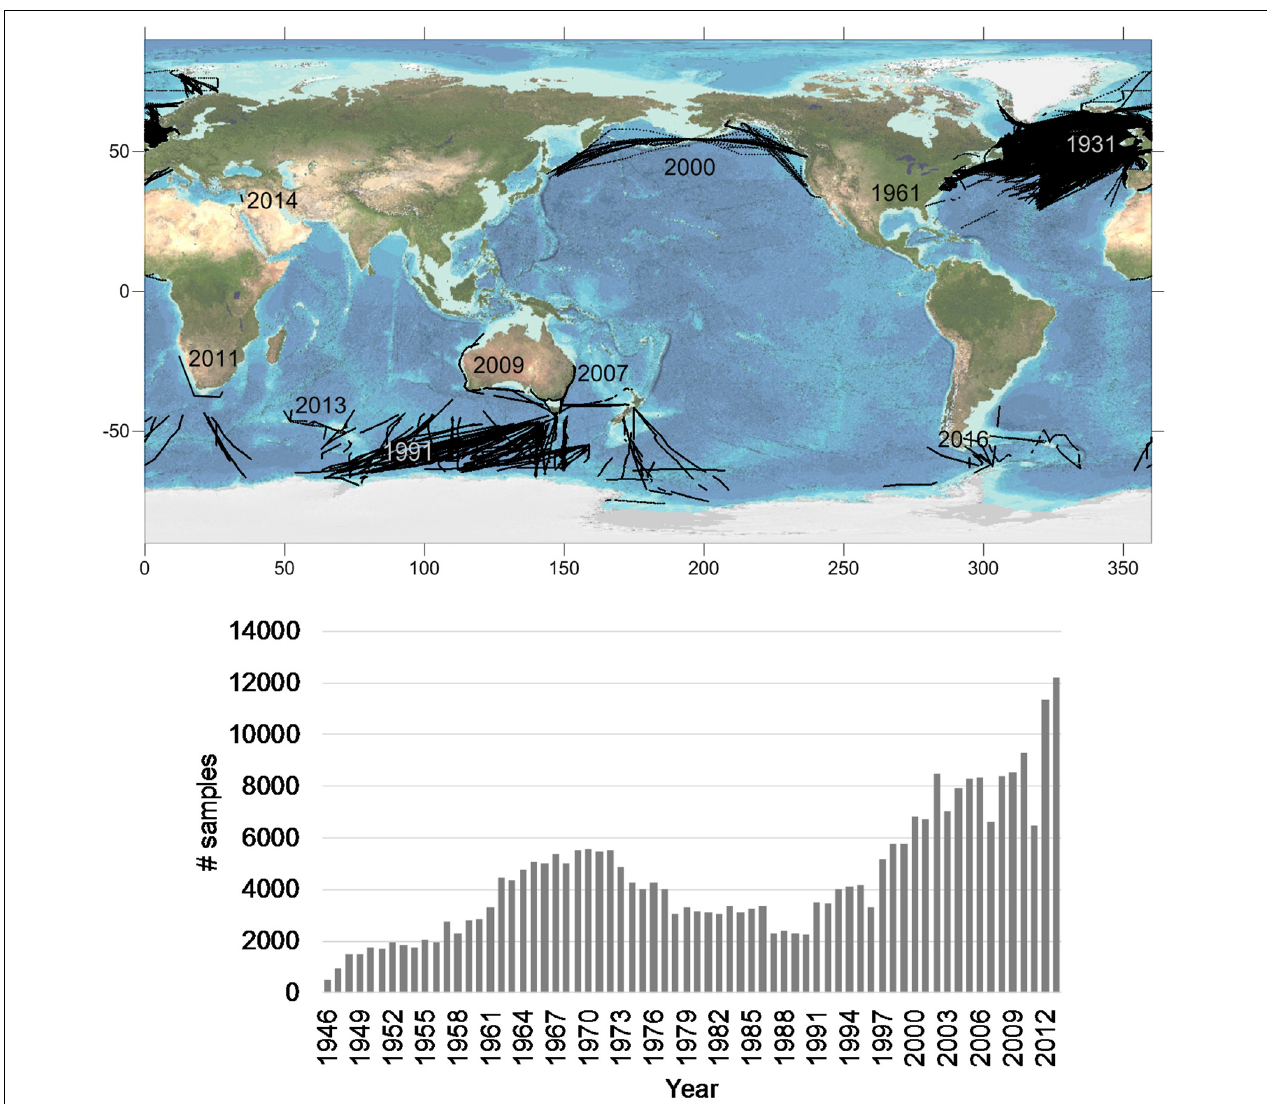
FIGURE 1 | Upper panel shows the CPR transect locations together with the year of inception of that local survey. Lower panel shows the combined total number of CPR samples that have had plankton counts